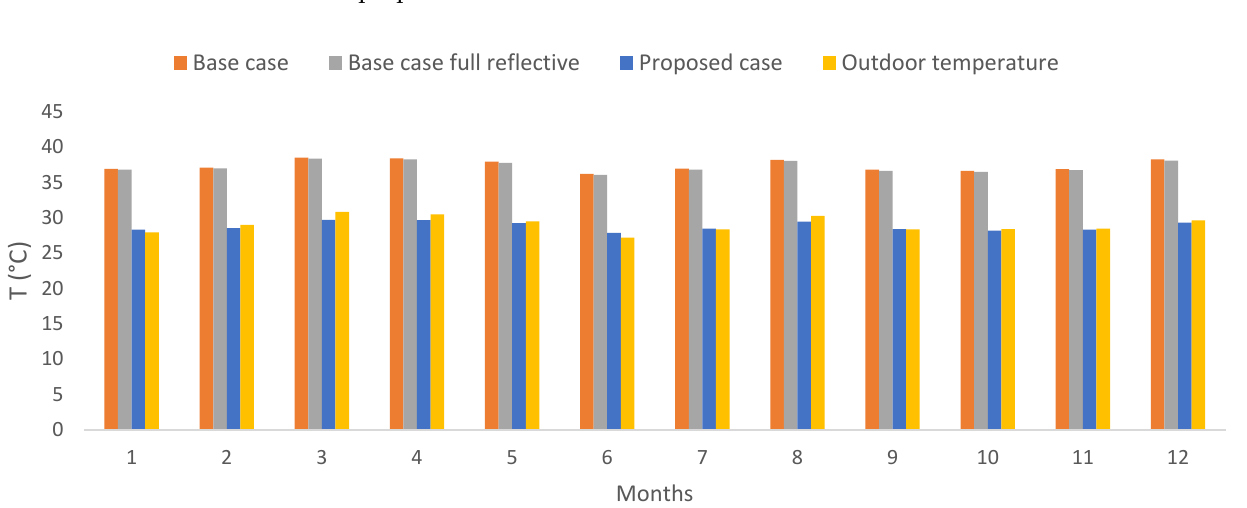
Figure 9. Monthly results of the operative temperature for the urban zone, only for occupied hours. Own elaboration.